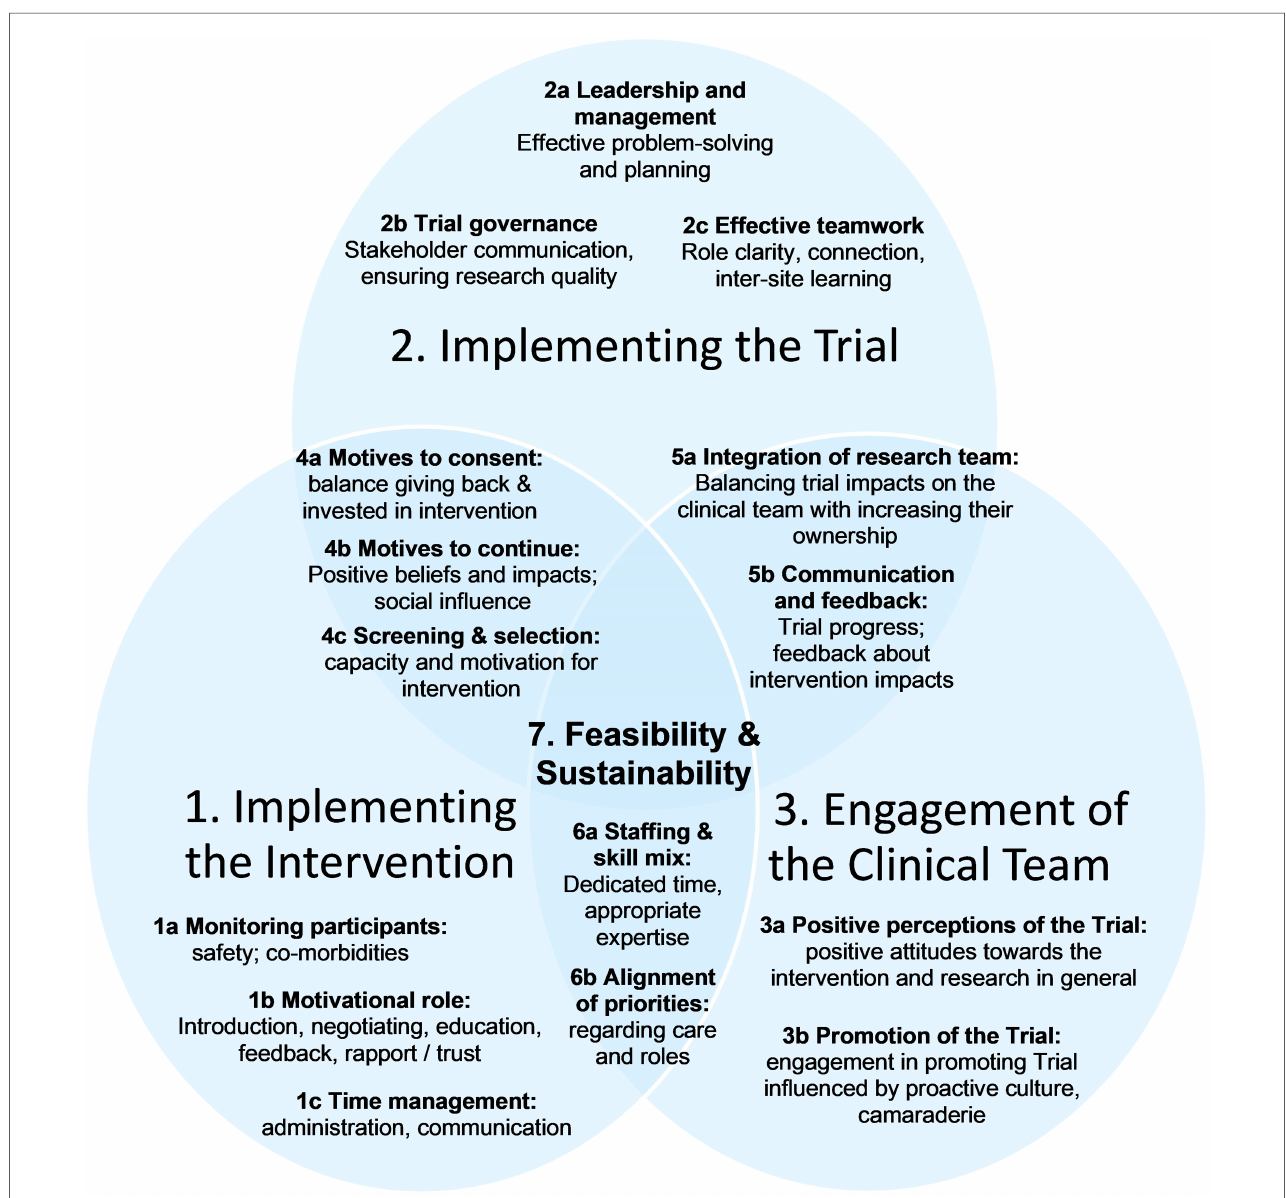
FIGURE 1 Explanatory theory: the ideal